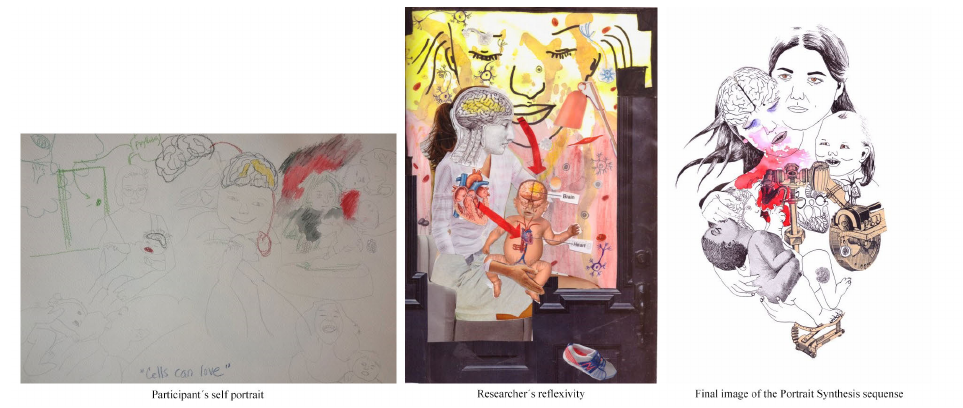
FFigigururee 2.2. TheThe crcreeationation ofof GabrielGabrielaa’’ss PPortrortraitait SSynthesisynthesis